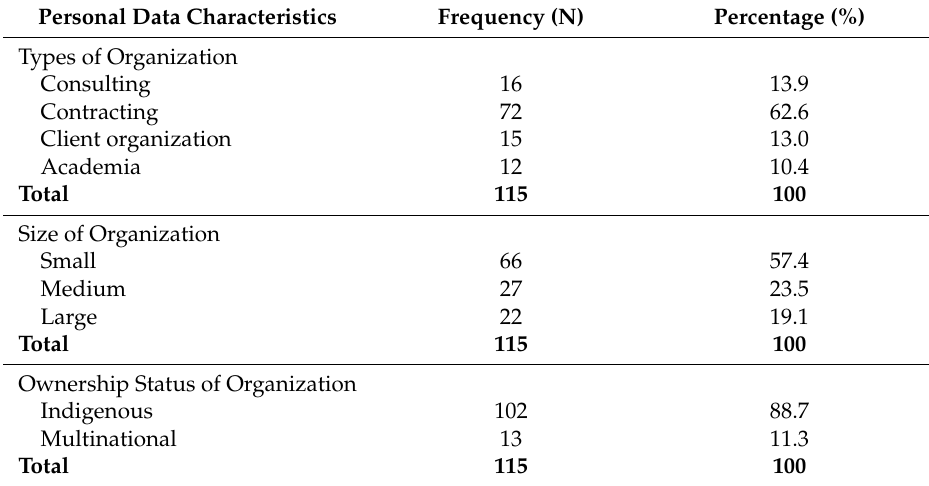
Table 1. Respondents’ organization details and personal